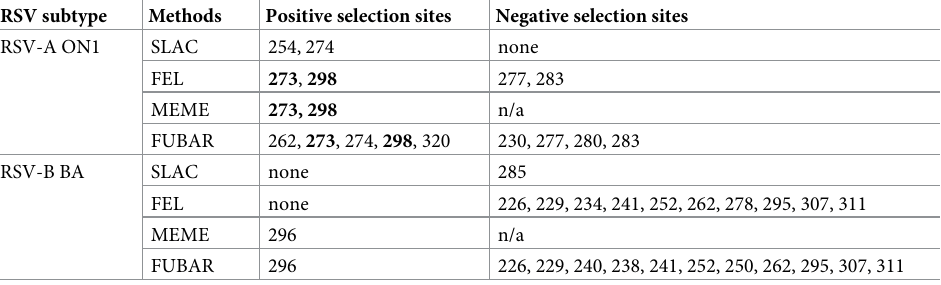
Table 3. Positive and negative selection sites in the partial G gene of RSV-A ON1 and RSV-B BA genotype using SLAC, FEL and MEME with a p-value threshold of 0.05 and FUBAR with a posterior probability of